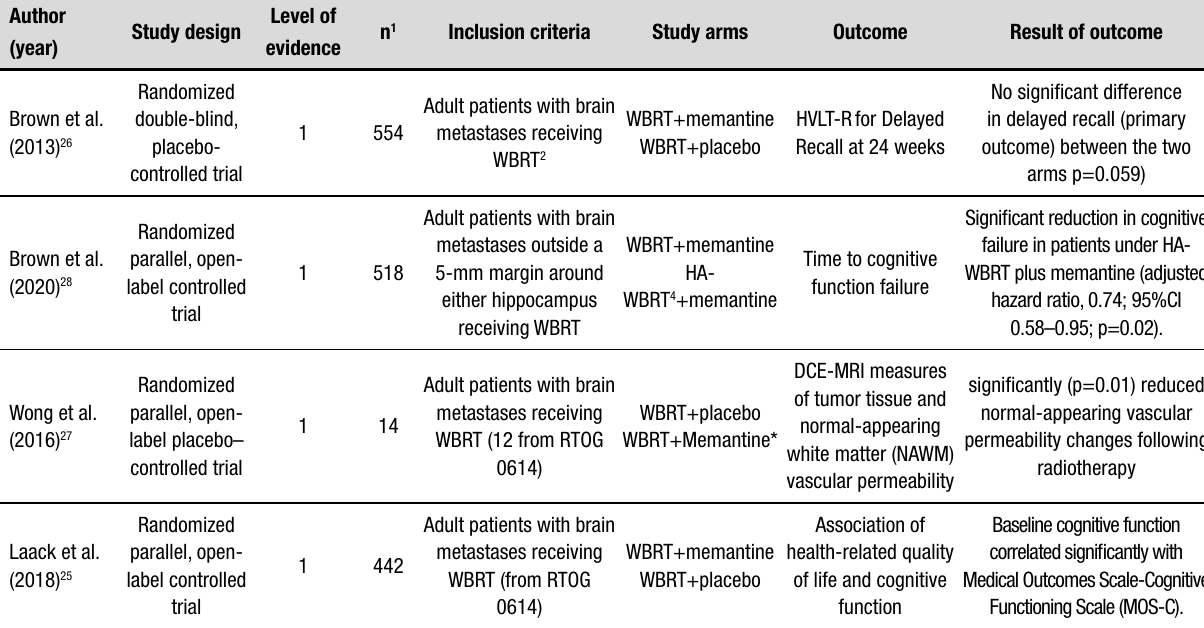
Table 1. Summary of the clinical studies on the effect of memantine for the prevention of cognitive dysfunction in patients with brain metastasis receiving whole-brain radiation therapy.